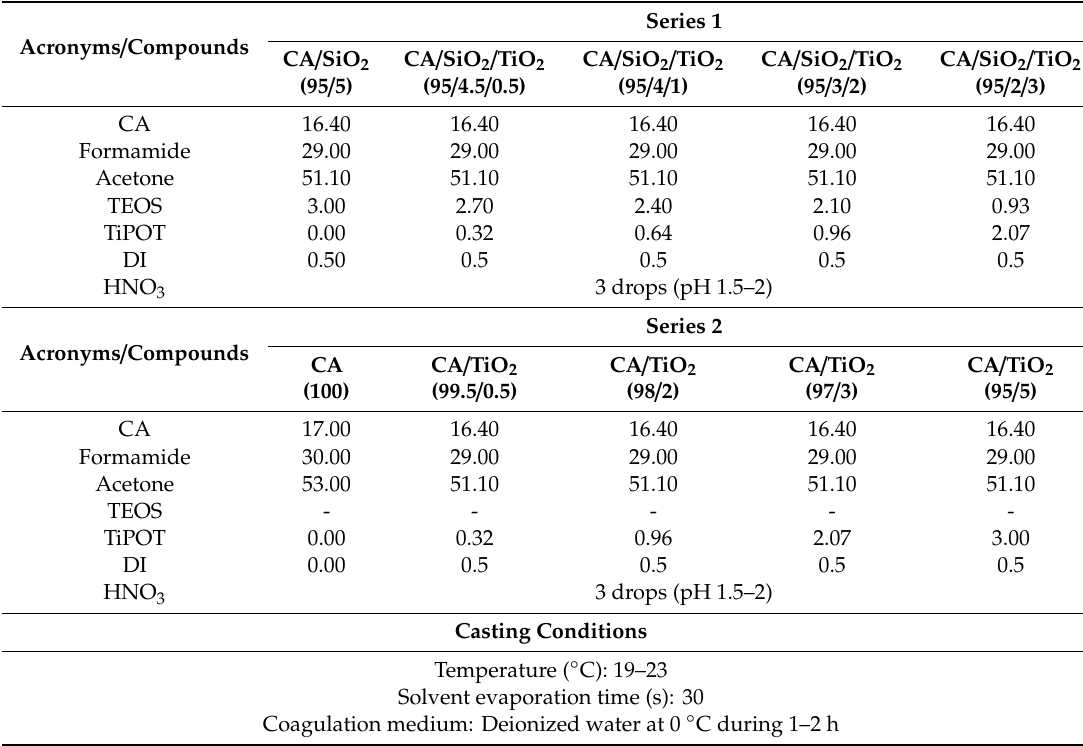
Table 1. Membrane acronyms and casting solution composition (series 1 and series